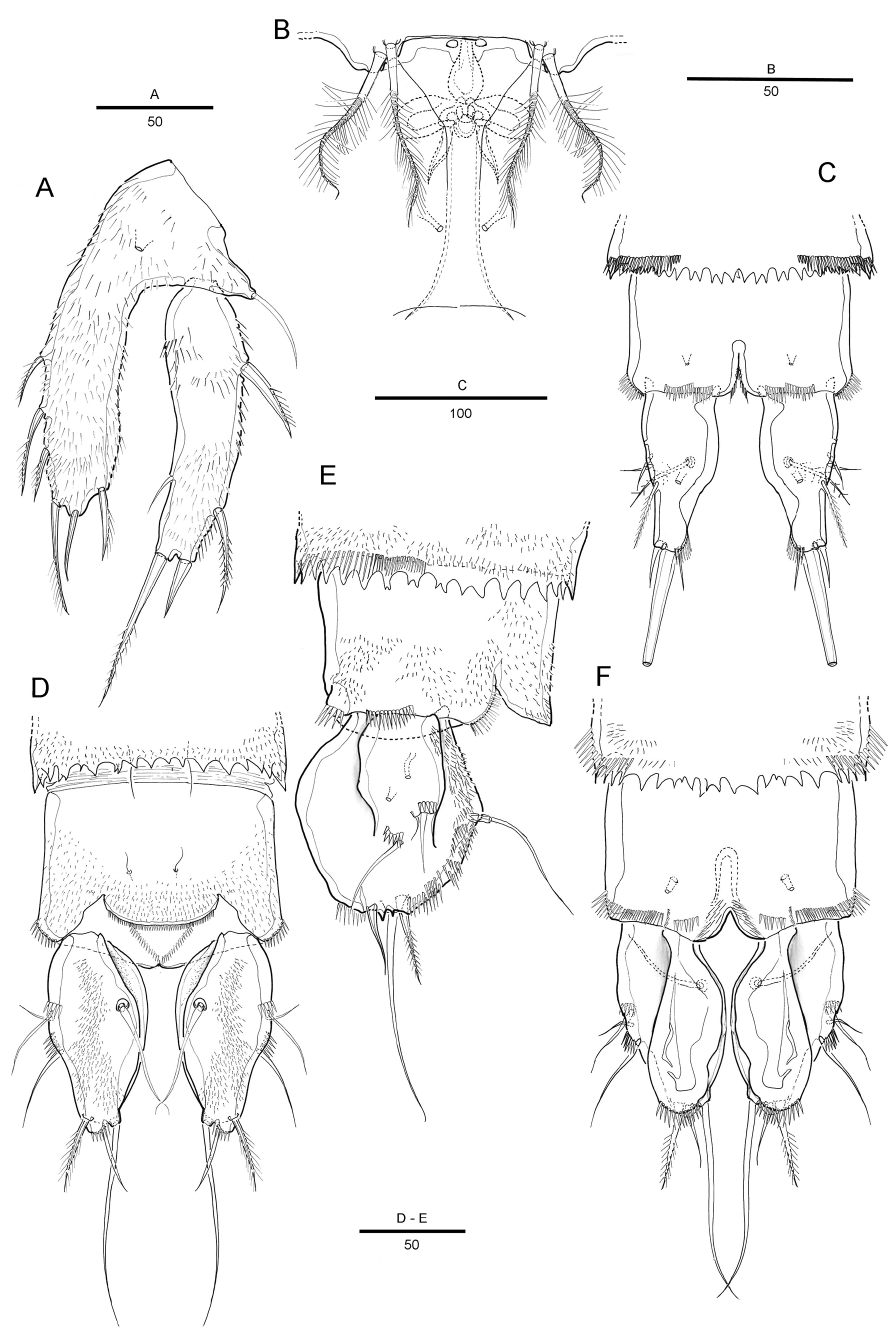
Figure 4. Attheyella ( Attheyella ) tahoensis sp. n. female: A P5, anterior B genital field, ventral C anal somite and caudal rami, ventral D abnormal caudal rami, dorsal E abnormal caudal rami, lateral F abnormal caudal rami,